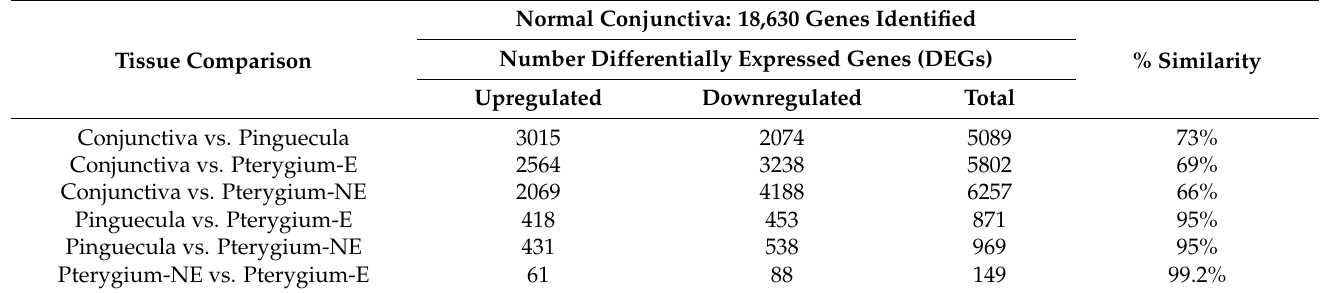
Table 1. Transcriptome Differences among Tissue Specimens.